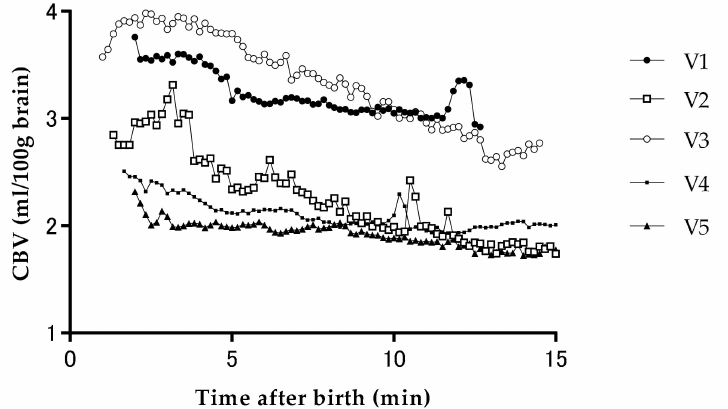
Figure 2. Cerebral blood volume (CBV) in five neonates during the first 15 min of life. Values are means. Compared with the reference value at 15 min, a significant decrease in CBV was observed at each time point.